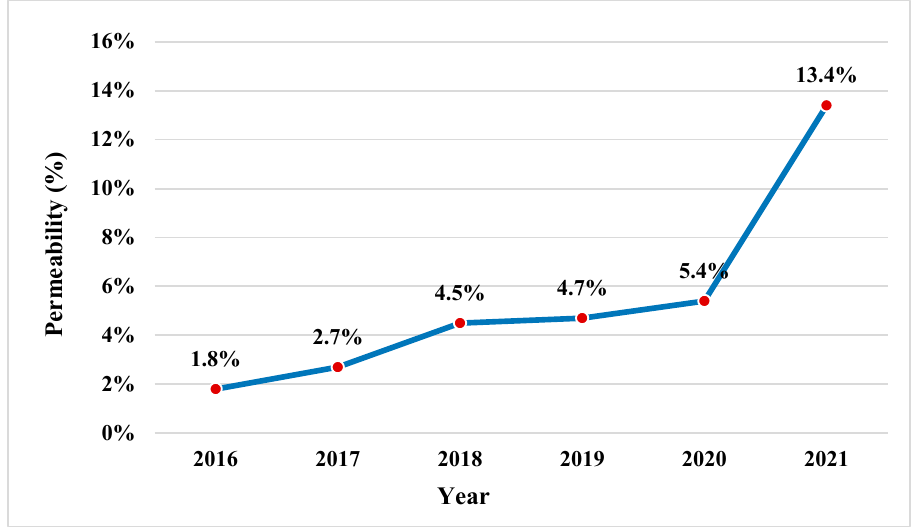
Figure 3. Trend of China’s new energy vehicle market penetration rate from 2016 to 2021.